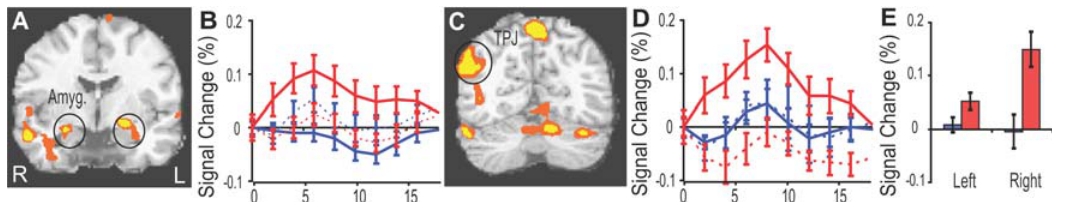
Figure 3. State by Group Interaction: A. (Amyg.) stands for amygdala (y= 2 5, color codes: orange, p , 2.10ˆ-3, yellow, p , 5.10ˆ-4). B. Impulse response in (Amyg.) for 15 experts (red) and for 15 novices (blue) during rest (dashed line) and compassion (full line). C–D. Same as A–B in TPJ; y= 2 61. E. Side by state effect and side by state by group effect in TPJ on the average impulse response between meditation and rest; experts are in red, novices in blue.